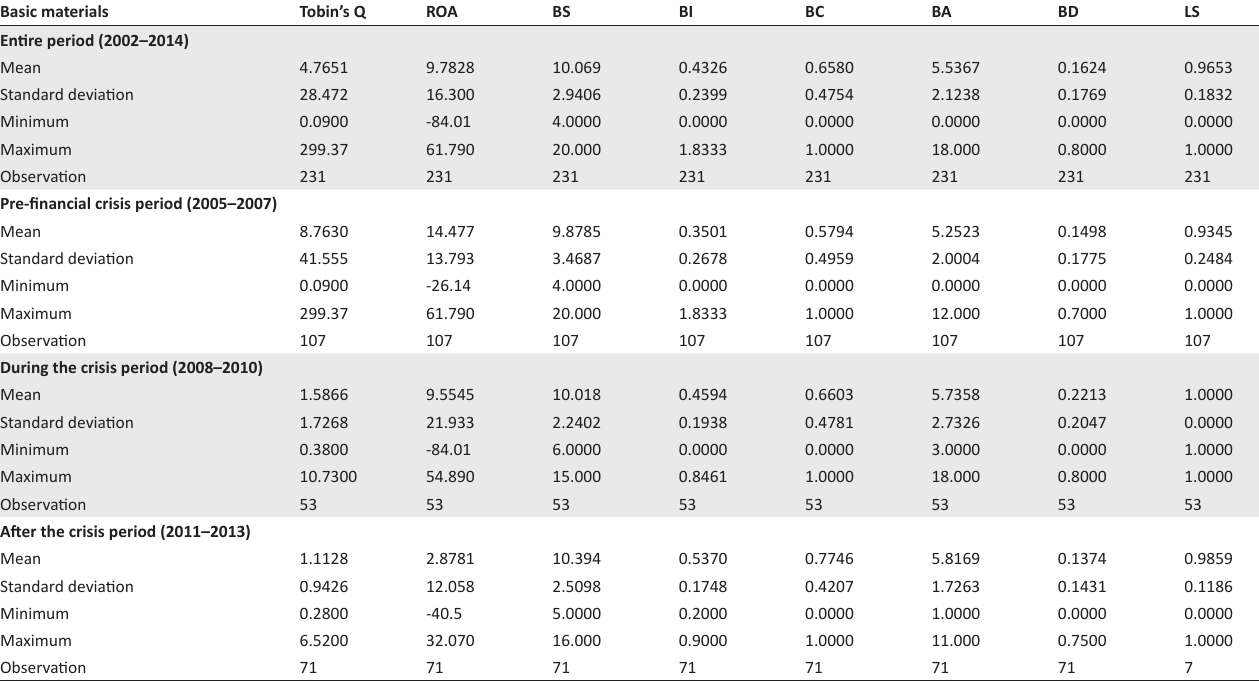
Table 1-A6: Descriptive statistics for the basic materials